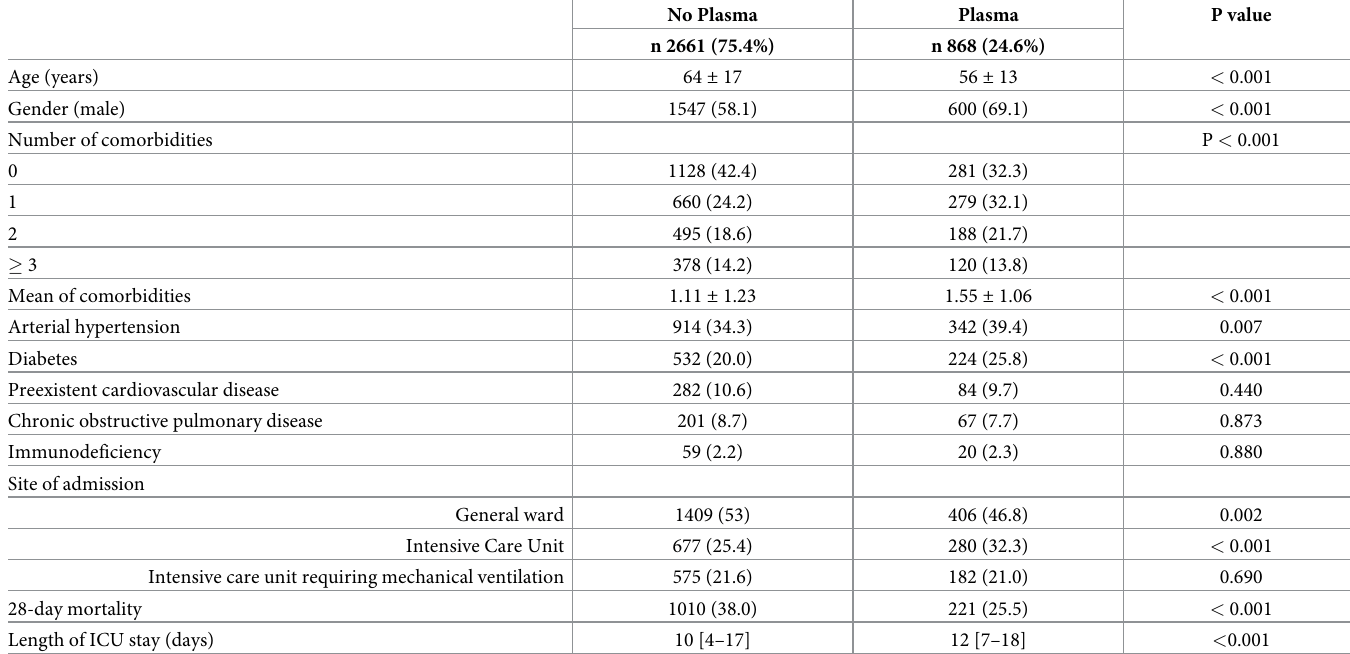
Table 2. Characteristics of patients receiving and non-receiving convalescent plasma.